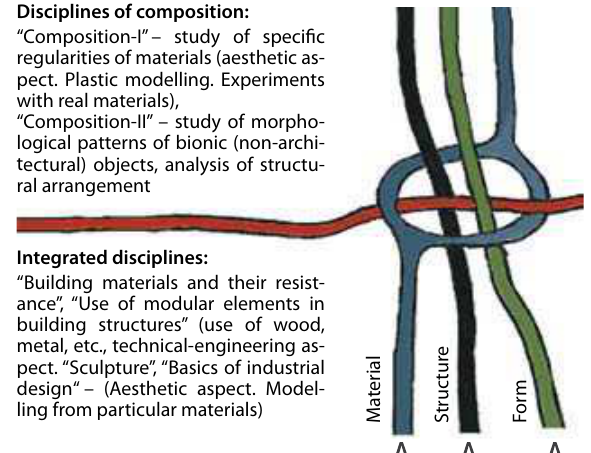
Fig. 2. Position of the main tectonic elements in the three- levelled model. Contents and interrelation of Architectural Composition and integrated disciplines at each level. The first level. Dominant tectonic element – material